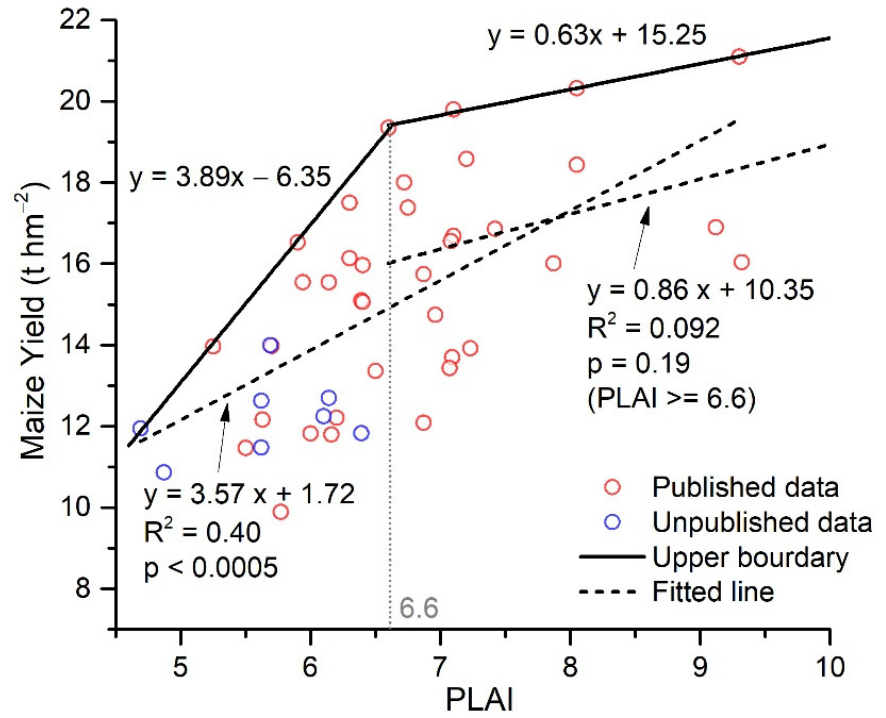
Figure 2. Maize yield against growing season maximum leaf area index (LAI max ) over China. Red circles denote data retrieved from 21 published [45–65] and 8 unpublished trials. For one trial involving multiple treatments or maize spices, the data pair from the highest yield treatment of each species was picked up. Blue circles denote recent field trails that have not been published yet.